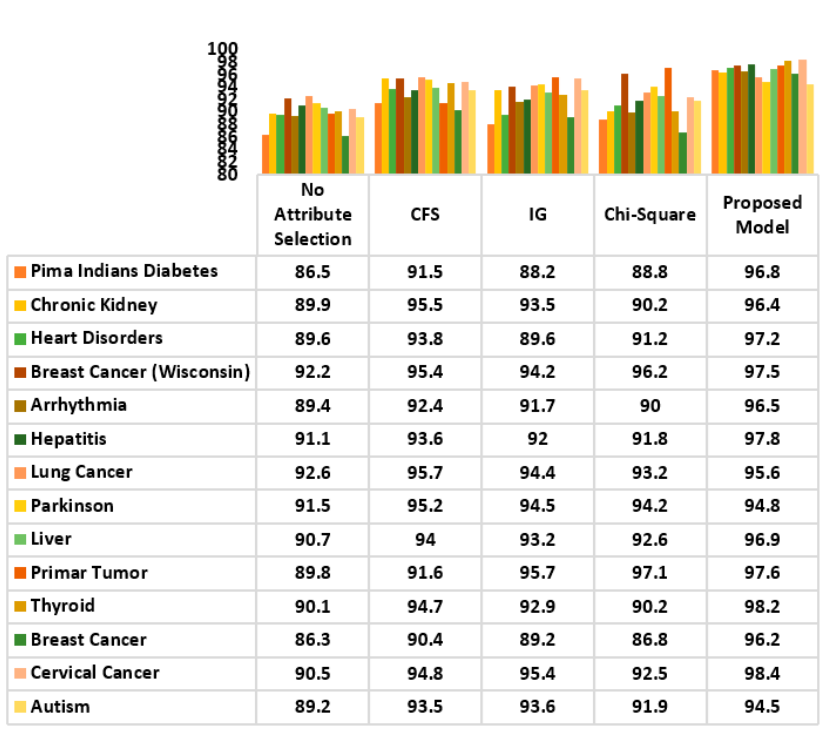
Figure 18. Comparative Study of the Classification Accuracy of the Proposed Attribute Evaluator Method and Other Filter Methods.